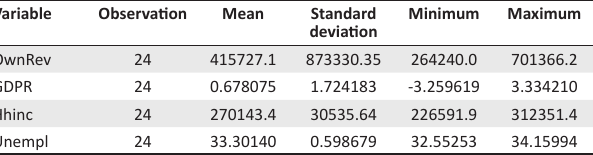
TABLE 2: Descriptive statistics.